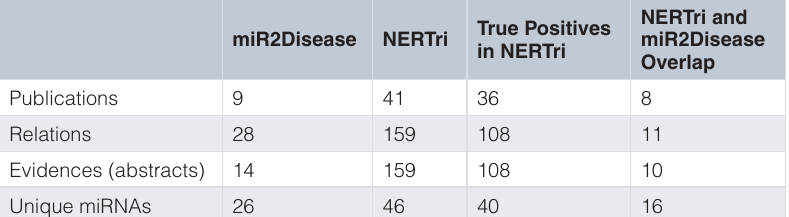
Table 7. miR2Disease database comparison. MiRNA-Alzheimer’s disease relation retrieved from MEDLINE and in miR2Disease database.